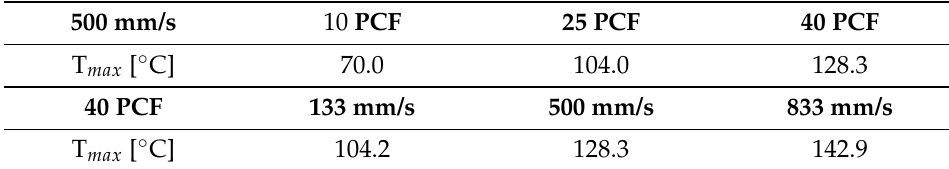
Table 5. Maximum temperature T max [ ◦ C] obtained from FE analyses for three analysed PUR foams with different densities (with constant cutting speed 500 mm/s) and various cutting speeds (with constant density of 40 PCF).